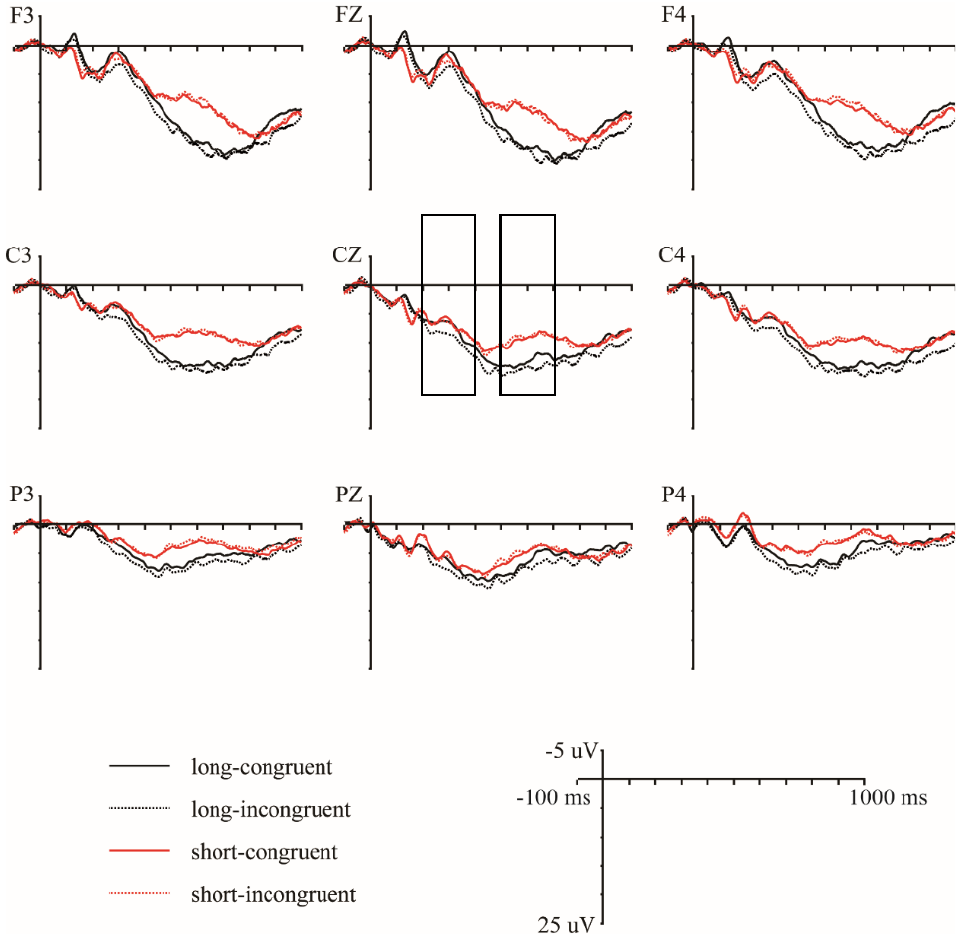
Figure 2. Grand average waveforms evoked by the target words primed by long–congruent, long–incongruent, short–congruent, and short–incongruent videos at nine selected electrode sites. Waveforms are time‑locked to the onset of the target words, and negative amplitudes are plotted up.